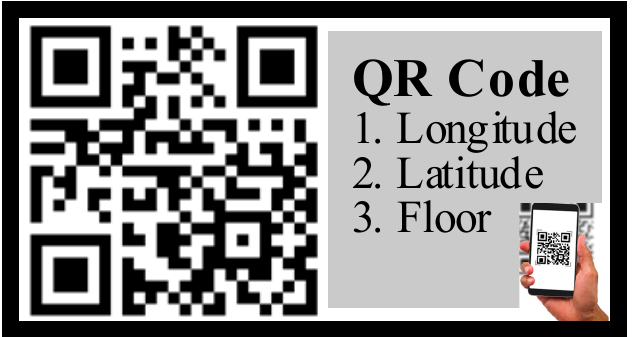
Figure 2. Acquirement of QR-Code-Based Reference Points.